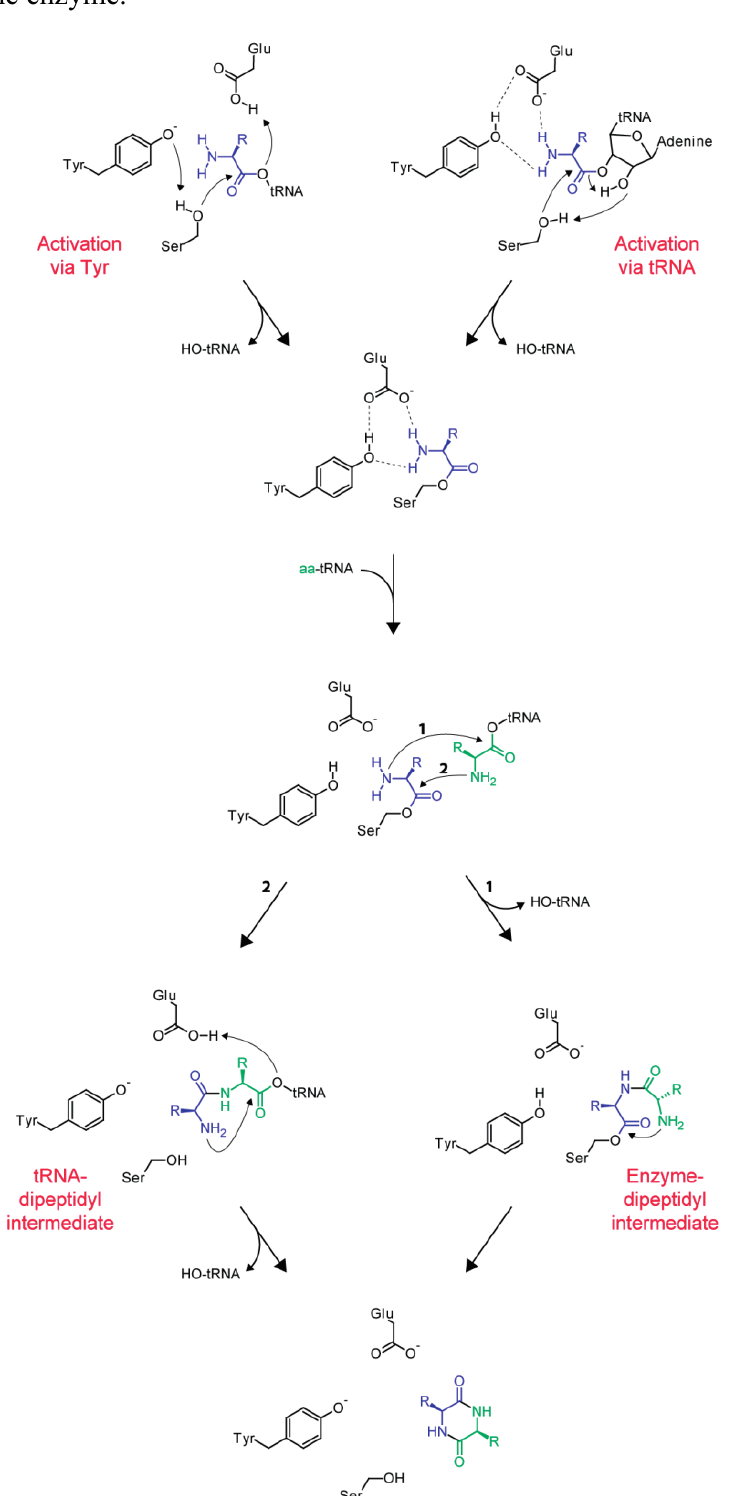
Figure 6. Proposed ping-pong mechanism of CDPS catalysis. Activation of the active site nucleophile (Ser) can be accomplished through interaction with a conserved tyrosine ( left ) or via a proton-shuttling mechanism involving the tRNA substrate ( right ). After the covalently bound aminoacyl-enzyme intermediate has been formed either an enzyme-dipeptidyl ( right ) or tRNA-dipeptidyl ( left ) intermediate is generated. Through attack of the α -amino group of the second aminoacyl moiety, the CDP is formed and released from the